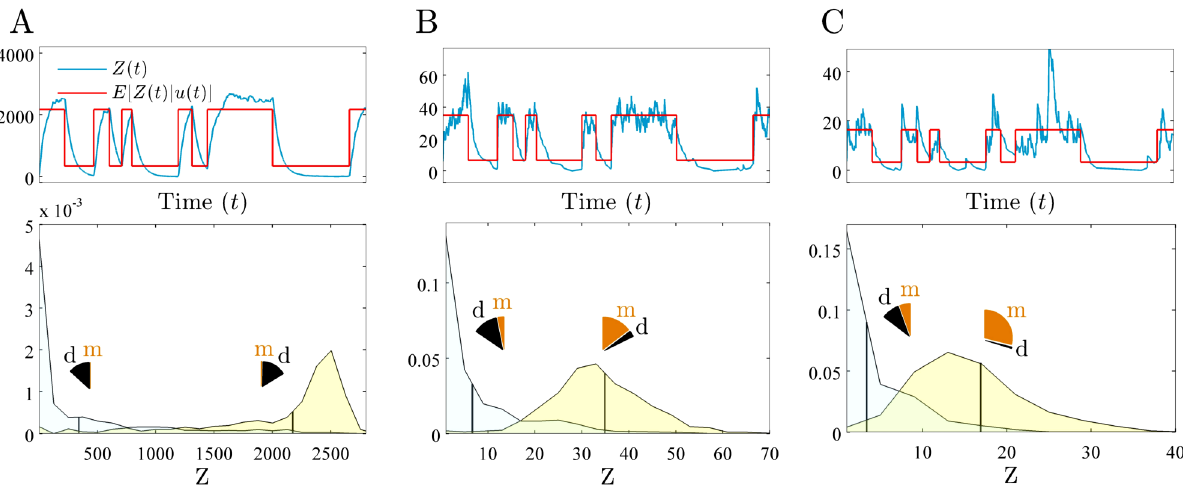
Figure 4. Increasing the strength of negative feedback decreases fidelity. We consider a 2-stage model of gene expression with the signal of interest s ( t ) ~ u ( t ) , and with u ( t ) proportional to the level of a transcriptional activator. We simulate u ( t ) as in Fig. 1A. Upper row compares the time course of the protein output (blue) to the faithfully transformed signal (red), E ½ Z ( t ) D u ( t ) (cid:2) . Lower row shows the distributions for the output, Z , that correspond to each of the two possible values of the input, u (low and high). Vertical lines indicate the means of the distributions. Pie charts show the fractions of the variance of each (conditional) distribution due to dynamical (d) and mechanistic (m) error, weighted by the probability of the input state: summing these gives the overall magnitude (variance) of the dynamical and mechanistic errors. (A) No feedback ( K 1 ~ 0 ), fidelity equals 2.4. (B) Intermediate feedback ( K 1 ~ 2 ), fidelity equals 2.0. (C) Strong feedback ( K 1 ~ 10 ), fidelity equals 1.3. As the strength of feedback increases, the underlying state of the input is more difficult to infer (the conditional distributions overlap more) because increasing (relative) mechanistic error dominates the decreasing (relative) dynamical error. Note the decrease in the (relative) dynamical error when u ( t ) is in its high state (yellow conditional distribution) because stronger negative feedback gives faster initiation of transcription. Transcription propensities are given by u ( t ) = ½ 1 z K 1 Z ( t ) (cid:2) , and all parameters except K 1 are as in Fig. 3B.